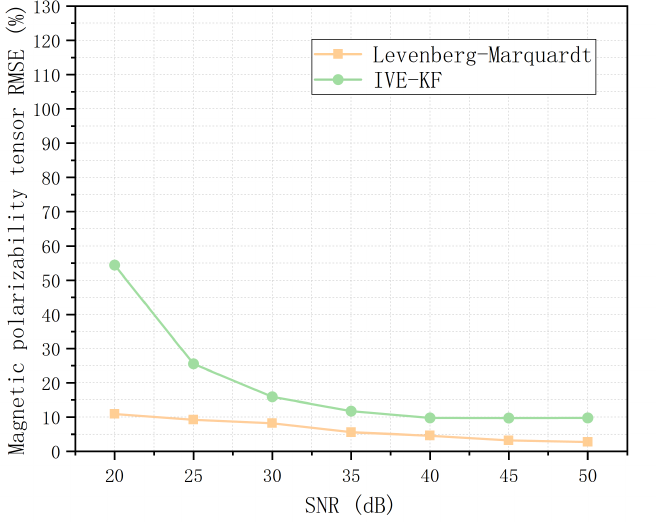
Figure 18. RMSE comparison of the magnetic polarizability tensor error of the inversion algorithm and filter